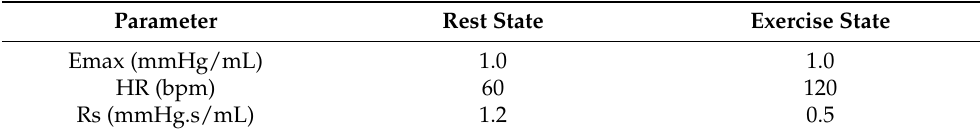
Table 2. Parameter settings for the physiological state. Parameter Rest State Exercise State Emax